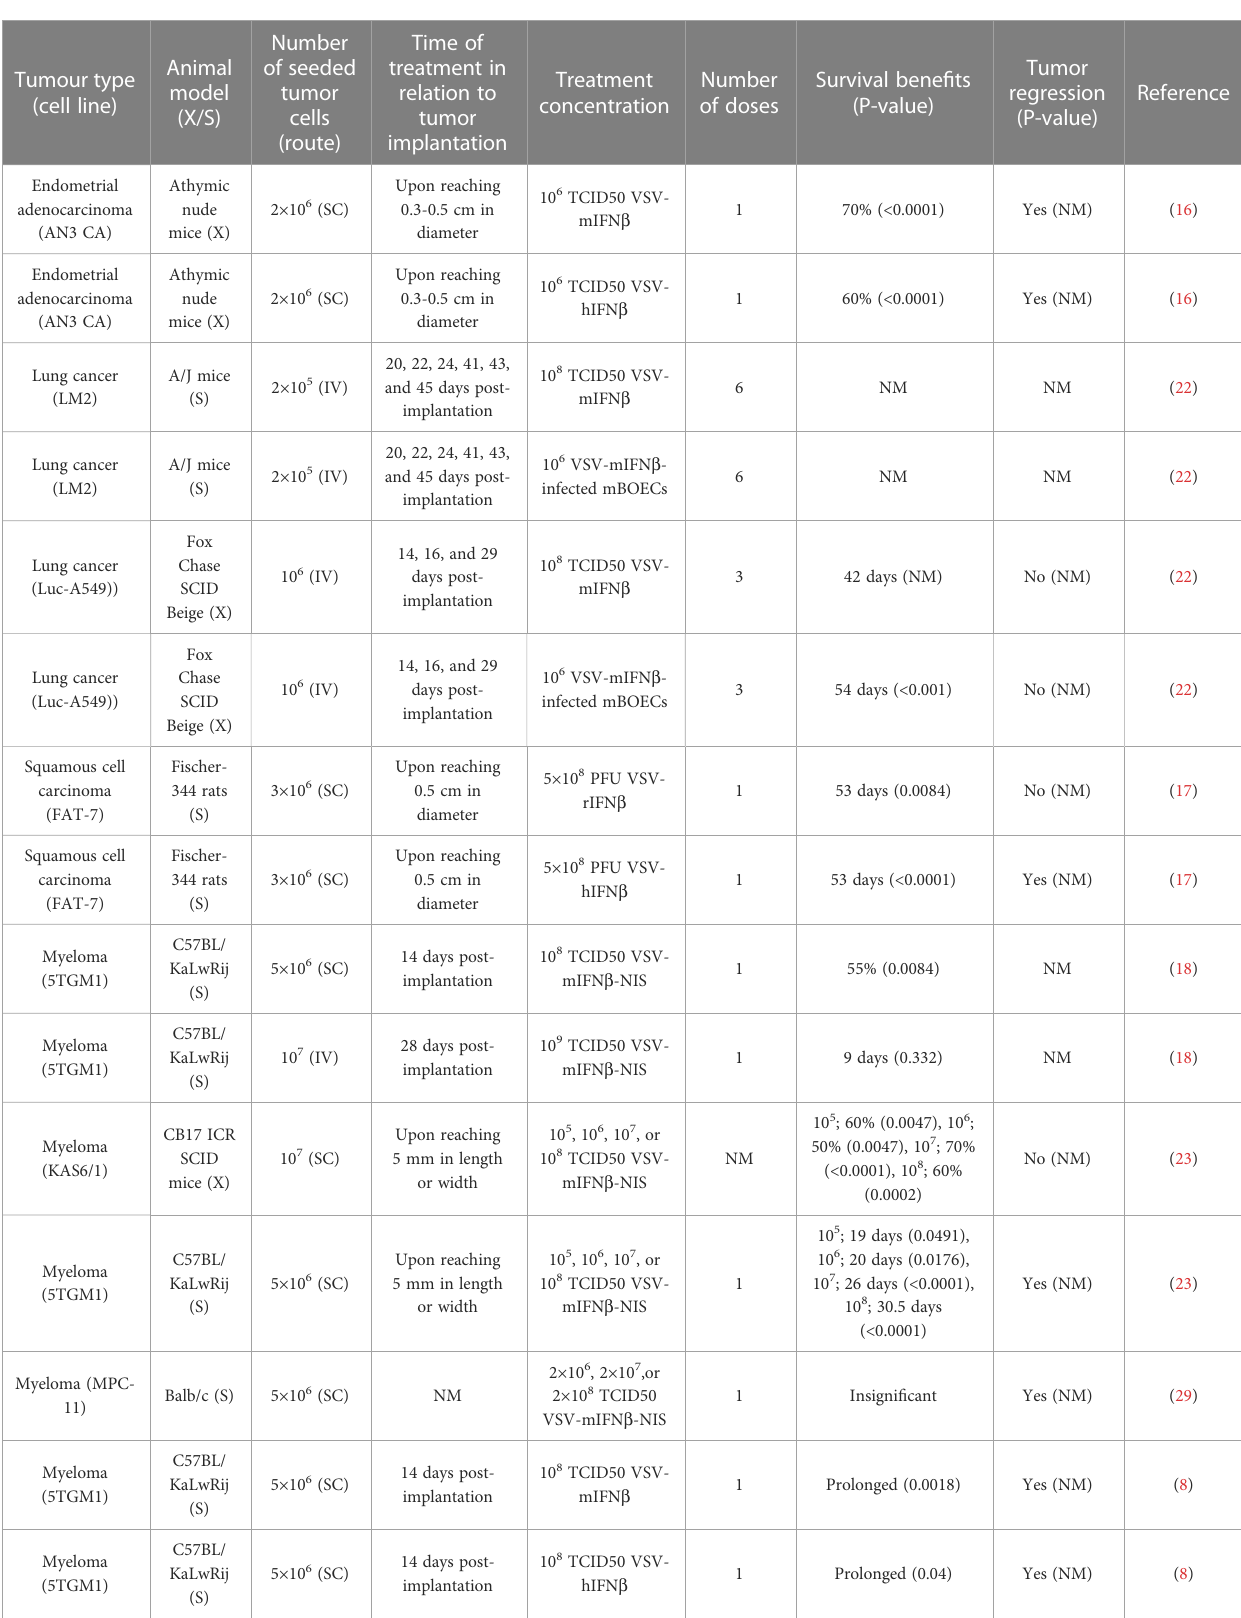
TABLE 4 Summary of the studies that utilized intravenous